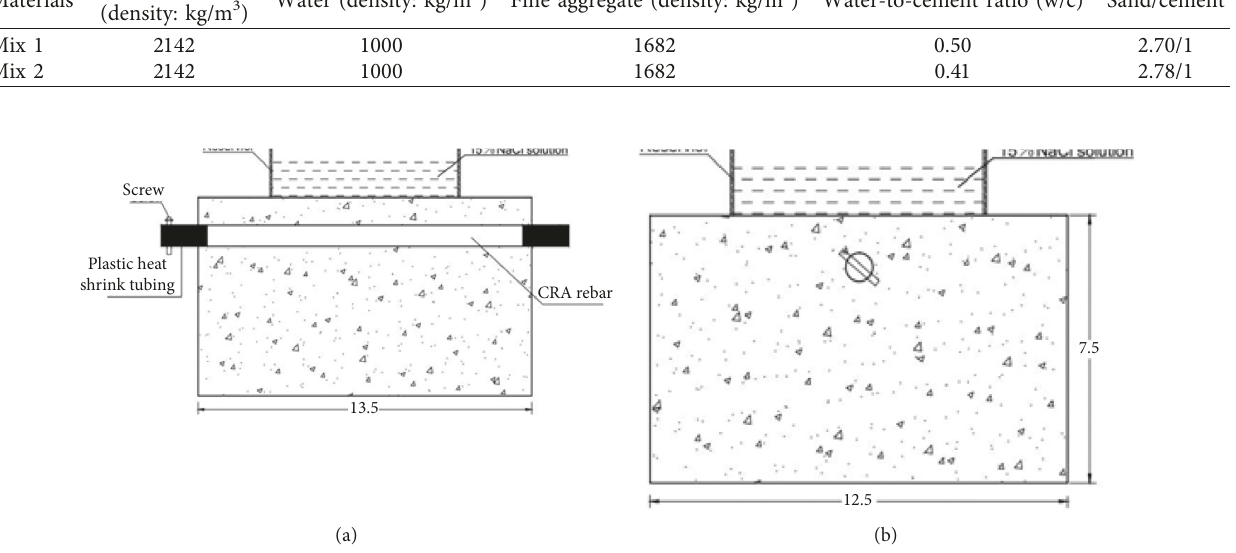
Figure 1: Schematic illustrations of the specimen: (a) cross section in parallel with the rebar direction; (b) front view (units: mm).